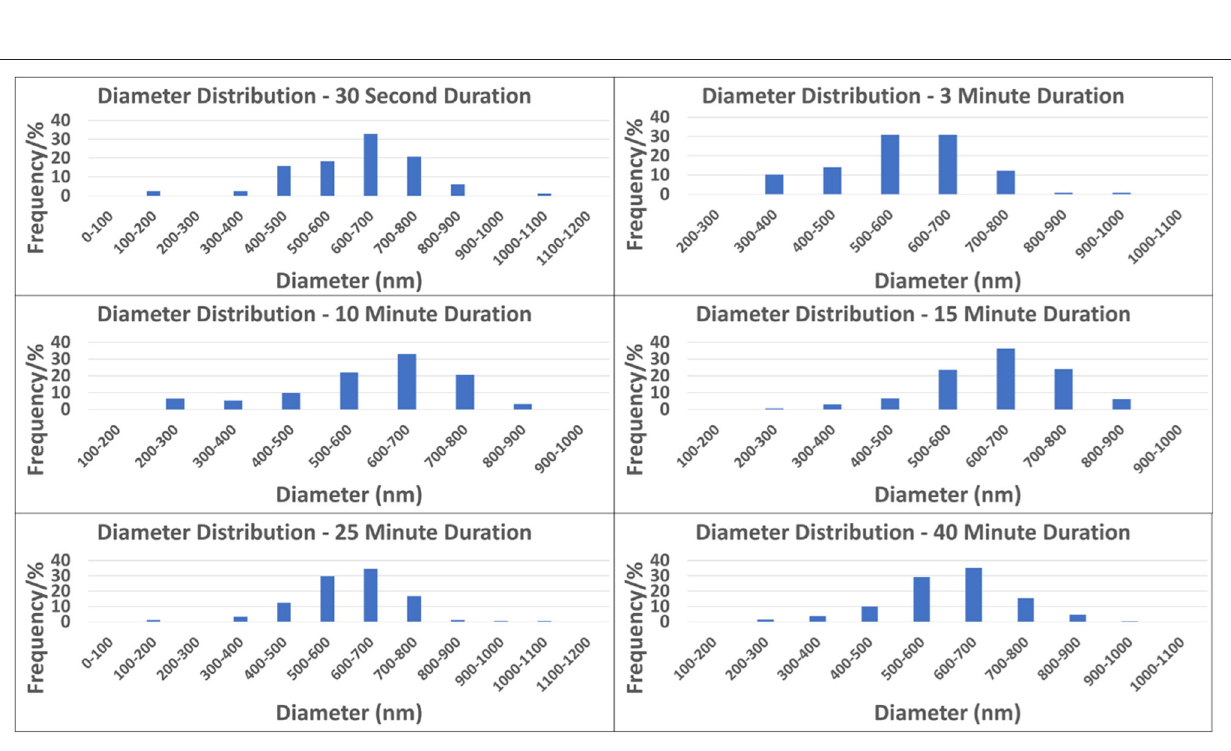
Frontiers in Chemistry |